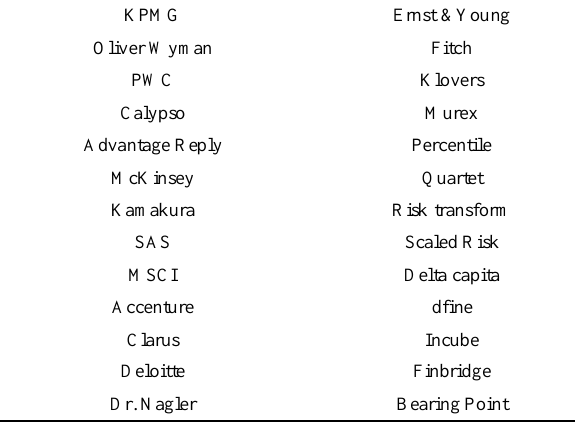
Table 1. Short overview of consultancies which offer new models for